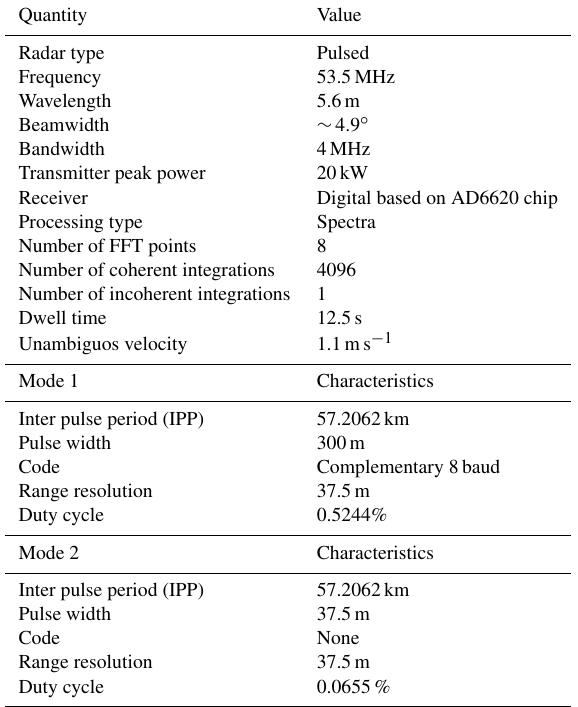
Table 1. SOUSY radar